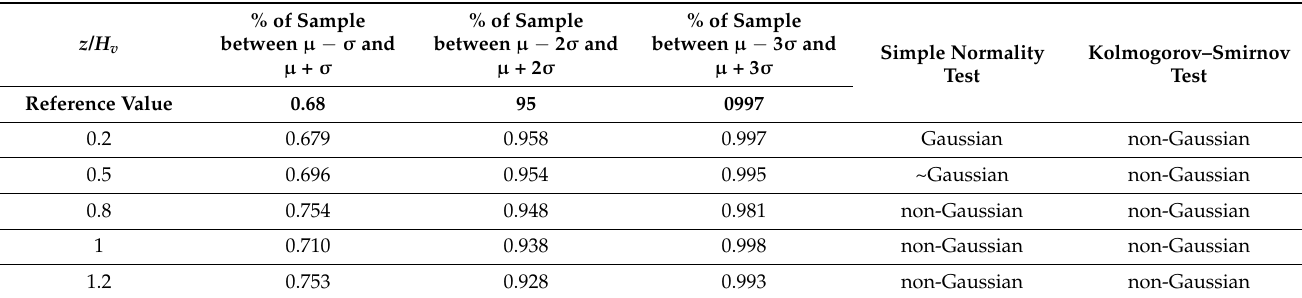
Table 2. Results of the normality test of velocity time series of case 1 at a distance of x/H v =8. Note that the unmatched values are